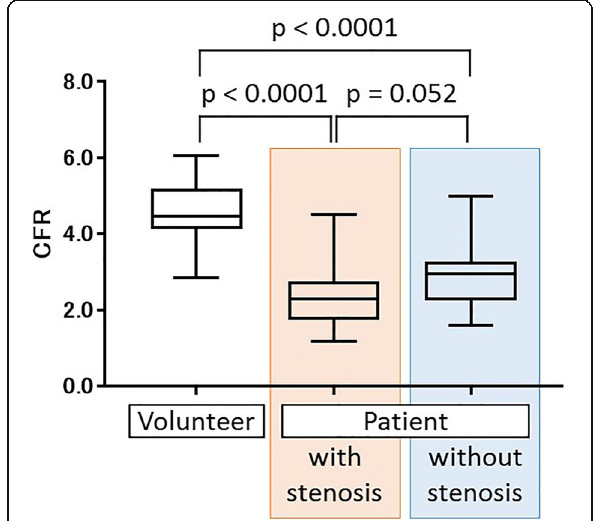
Fig. 3 The regional CFR values of the healthy volunteers were significantly higher than those of the patients (4.53 ± 0.82 vs 2.63 ± 0.88, p < 0.0001). Among the patients, the CFR values of the stenotic regions tended to be lower compared to those of the non-stenotic regions (2.43 ± 0.81 vs 2.95 ± 0.95, p =